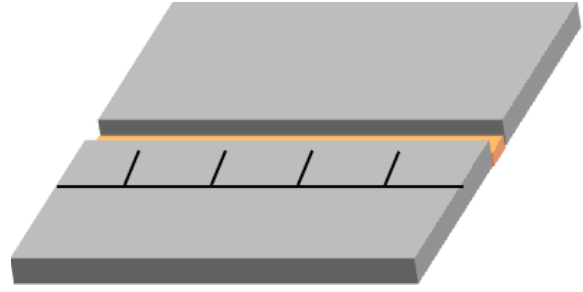
Figure 13. The schematic diagram of the groove.